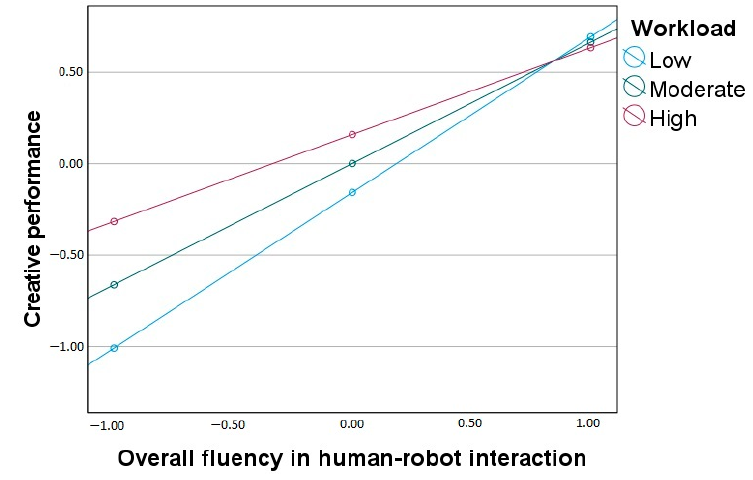
Figure 3. Workload as a moderator between overall fluency in human-robot interaction and creative performance.